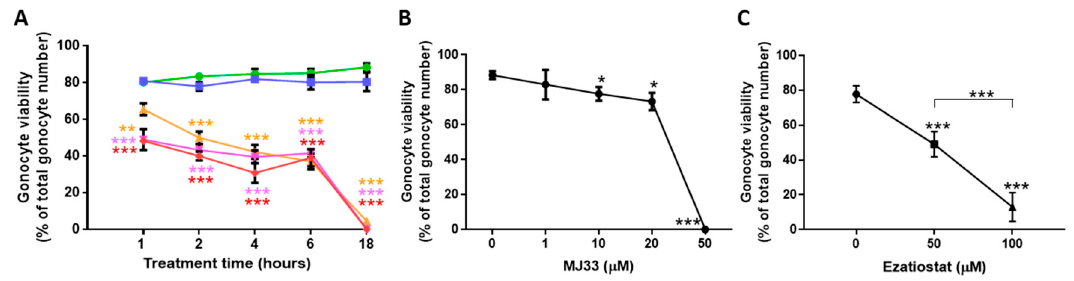
Figure 3. Effects of PRDX inhibitors on PND3 gonocyte viability. Cell viability was determined by trypan blue exclusion method. ( A ) Dose response and time course of conoidin A effects. Control: green; Conoidin A at 0.1 μ M (blue); 1 μ M (orange); 5 μ M (pink); 10 μ M (red). ( B ) MJ33 dose response at 18 h treatments. ( C ) Ezatiostat dose response at two hours of treatment. Results represent the means